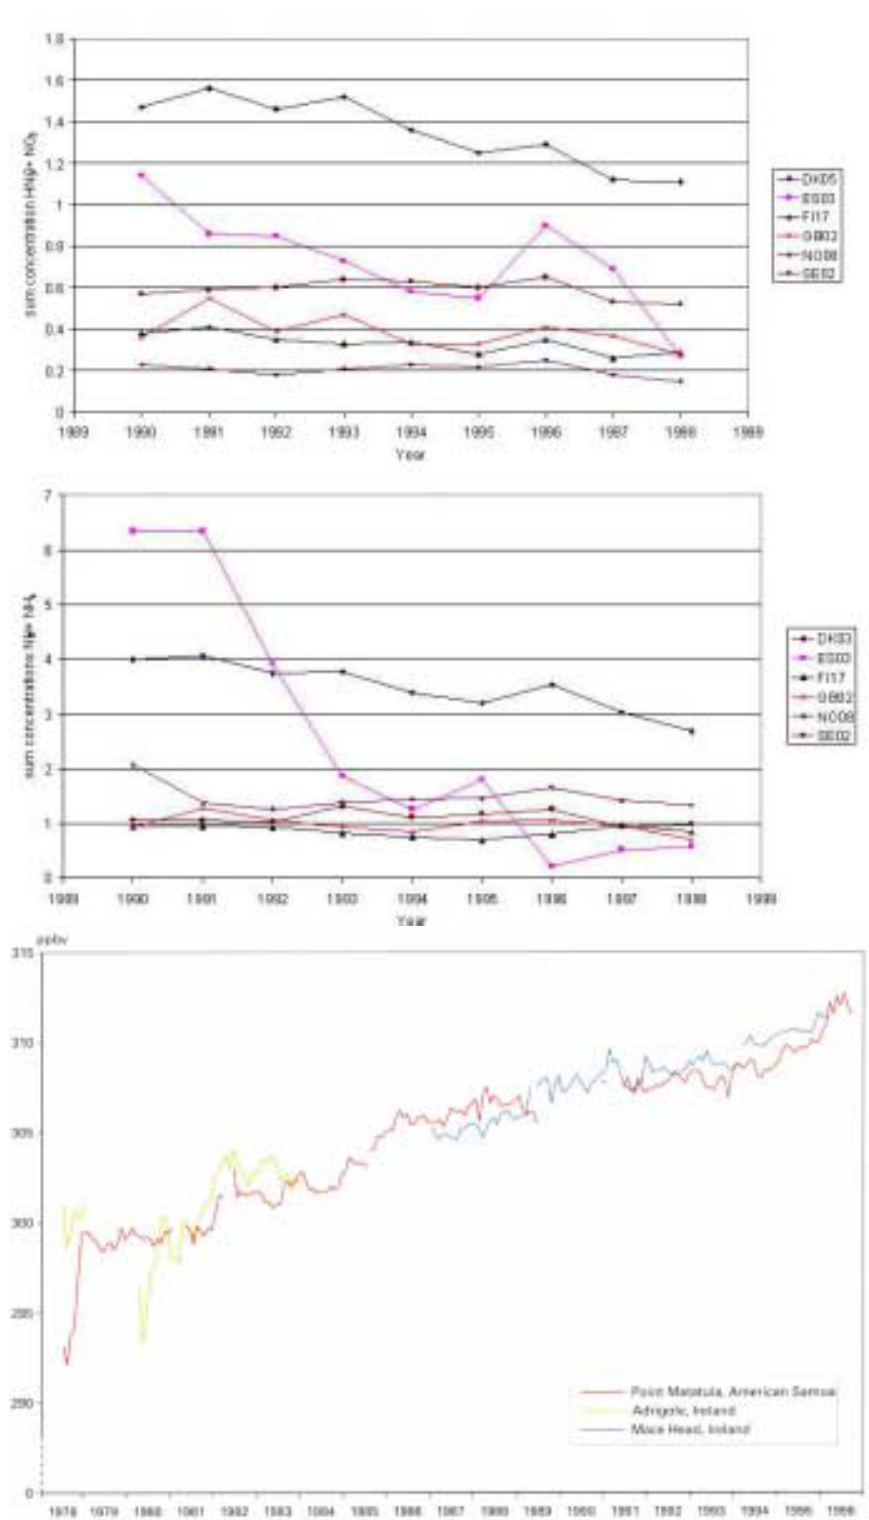
FIGURE 5. Ambient concentration measurements from the EMEP network for total nitrate (HNO 3 +NO 3 ) (A) and total ammonium (NH 3 +NH 4 ) (B) in µg m -3 and N 2 O concentration (C) measurements in ppm made in